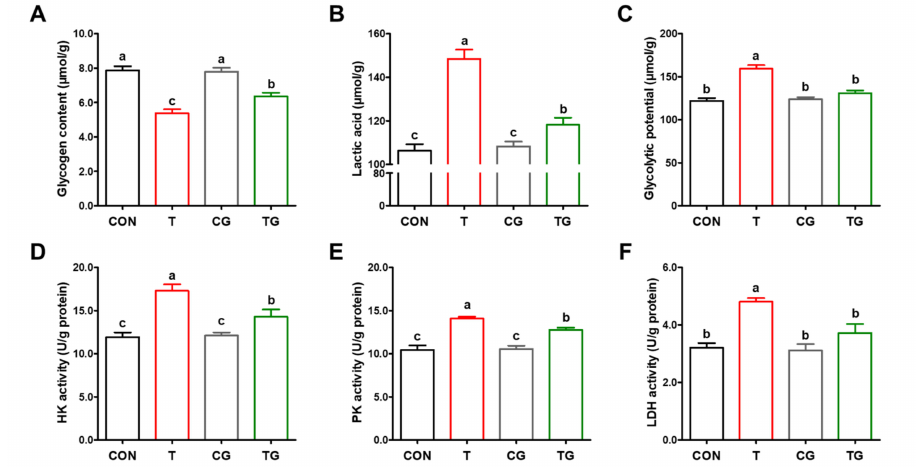
Figure 3. Effects of heat shock protein 70 expression on glycolytic parameters and activities of glycolytic enzymes in pectoralis major muscles of broiler chickens subjected to pre-slaughter transport. ( A ) Glycogen content. ( B ) Lactic acid concentration. ( C ) Glycolytic potential. ( D ) Hexokinase activity. ( E ) Pyruvate kinase activity. ( F ) Lactate dehydrogenase activity. ( F ). CON, broilers that received intraperitoneal injection of saline and were held under a normal rearing condition; T, broilers that received intraperitoneal injection of saline and were subjected to pre-slaughter transport treatment; CG, broilers that received intraperitoneal injection of glutamine and were held under a normal rearing condition; TG, broilers that received intraperitoneal injection of glutamine and were subjected to pre-slaughter transport treatment. All measurements are expressed as means ± SE ( n = 6) with different superscript letters (a–c) indicating significance ( p <